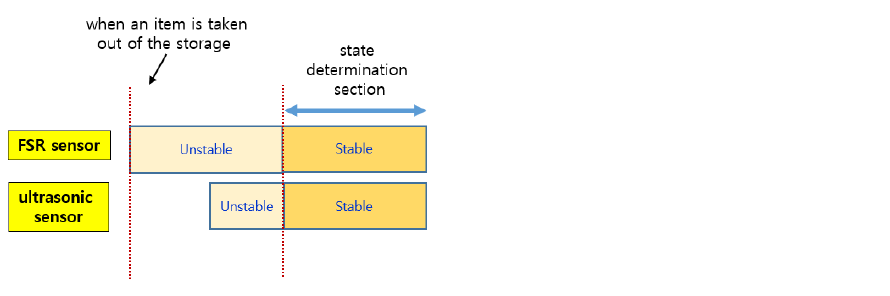
Figure 10. The sections for the FSR sensor and the ultrasonic sensor when an item is taken out of the smart storage.